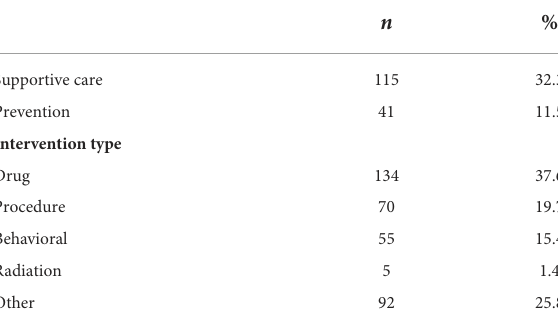
TABLE 1 Characteristics of clinical trials in cancer-related